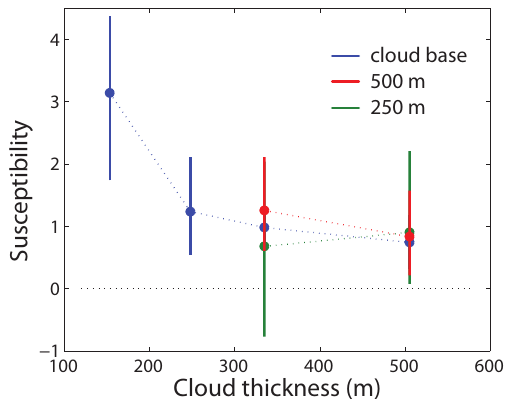
Fig. 5. The precipitation susceptibilities of drizzle at cloud base (blue), at 500m (red), and at 250m (green) are calculated. Precipita- tion rates are averaged over 10km segments. While the same Z − R relationship ( Z = 0 . 4 R 1 . 3 ) from Comstock et al. (2004) is used for cloud base precipitation rates and 500 m precipitation rates, a dif- ferent Z − R relationship ( Z = 1 . 7 R 1 . 1 ) is used for the 250m pre- cipitation rates.